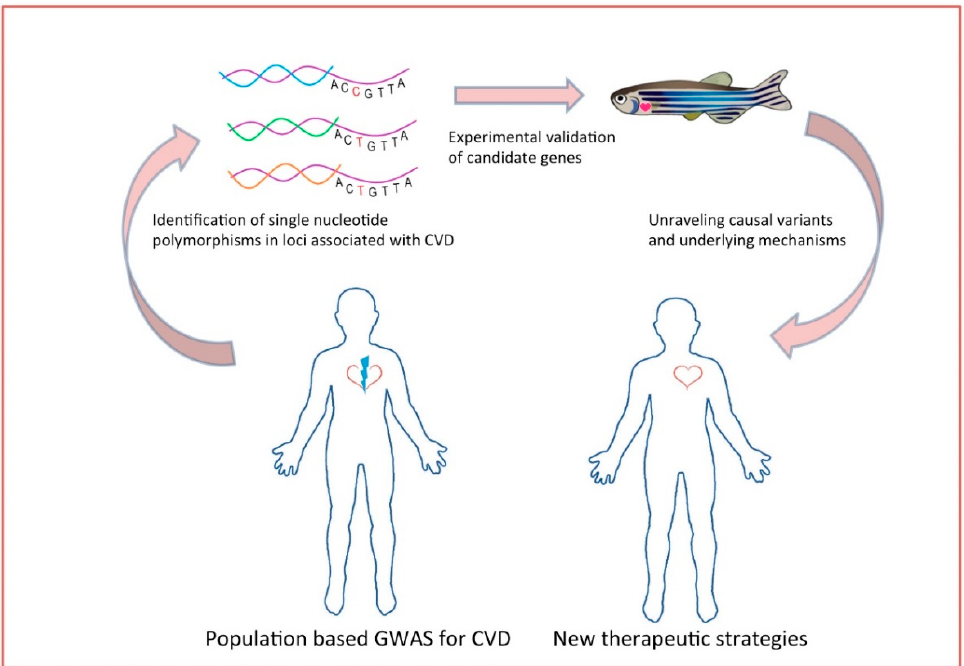
Figure 1. Next generation sequencing and genome-wide association studies (GWAS) studies identify multiple loci and polymorphisms that can be easily studied in vivo in zebrafish. CVD = cardiovascular disease.